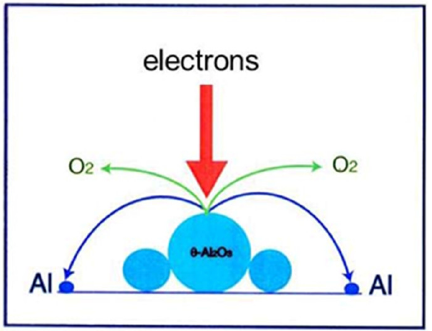
Figure 3. Schematic of Al nanodecahedra formation by electron irradiation in a TEM. Electrons cut the Al-O bond of metastable θ -Al 2 O 3 , which decomposes into Al and O atoms, and finally the Al atoms recombine to form twinned decahedra surrounded by {111} surfaces.